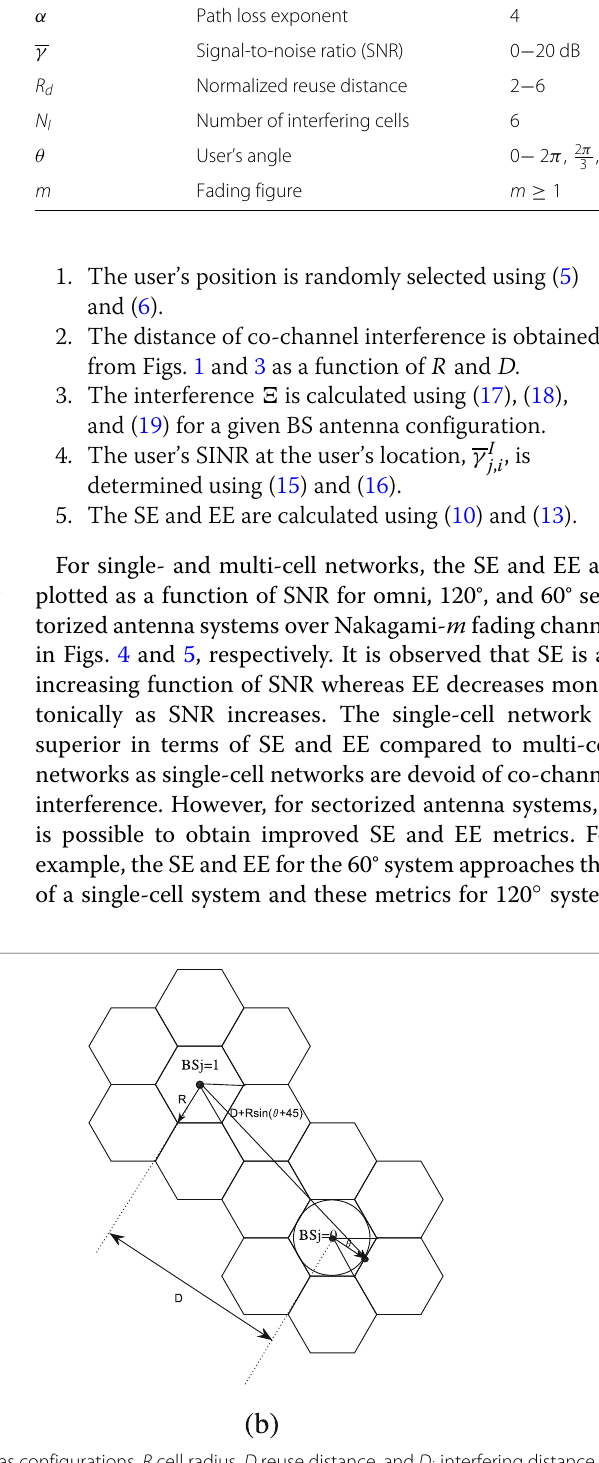
Fig. 3 Hexagonal cellular network with 120 ◦ and 60 ◦ sectorized antennas configurations. R cell radius, D reuse distance, and D i interfering distance. a 120° directivity. b 60°